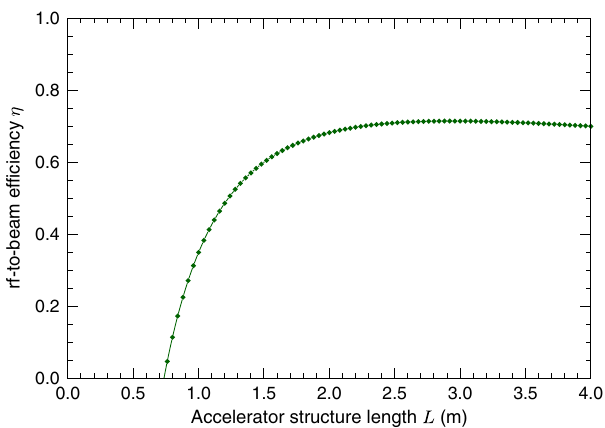
, beam intensity per keV; E b is the b